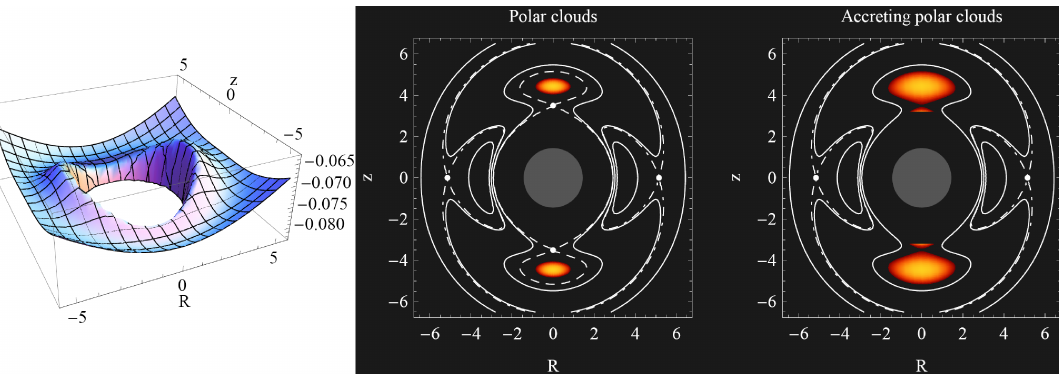
Figure 27. Typical behavior of the potential W for the charged fluid shown in terms of its poloidal profile (left) and poloidal equipotential contours (right). The behavior characterizes circulation of = kA , where k = the fluid with Ω = 1.6 10 − 3 and 1.3, in the field with the parameters − × K − a = 0.9, B = 6.5 10 − 5 and Q = 3.99 10 − 3 . The twice self-crossing dashed curve determines × × the critical polar lobes with the polar cusps, corresponding to the polar saddle points, while the twice self-crossing dot-dashed curve determines the pseudo-critical polar lobes with the equatorial pseudo-cusps, corresponding to the equatorial saddle points; the dots denote locations of the cusps and